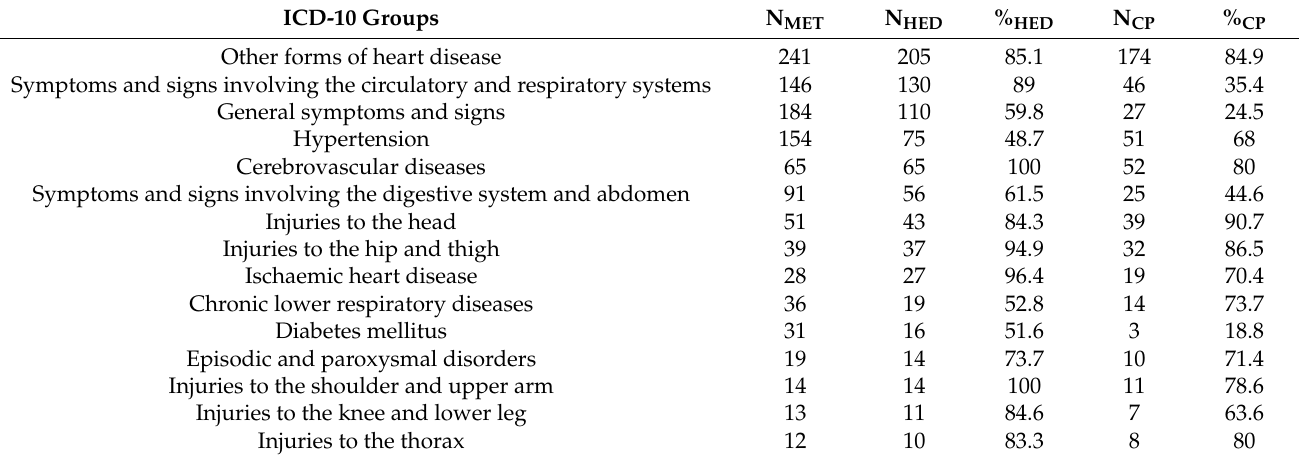
Table 7. The most common groups of (ICD-10) MET diagnoses leading to ED